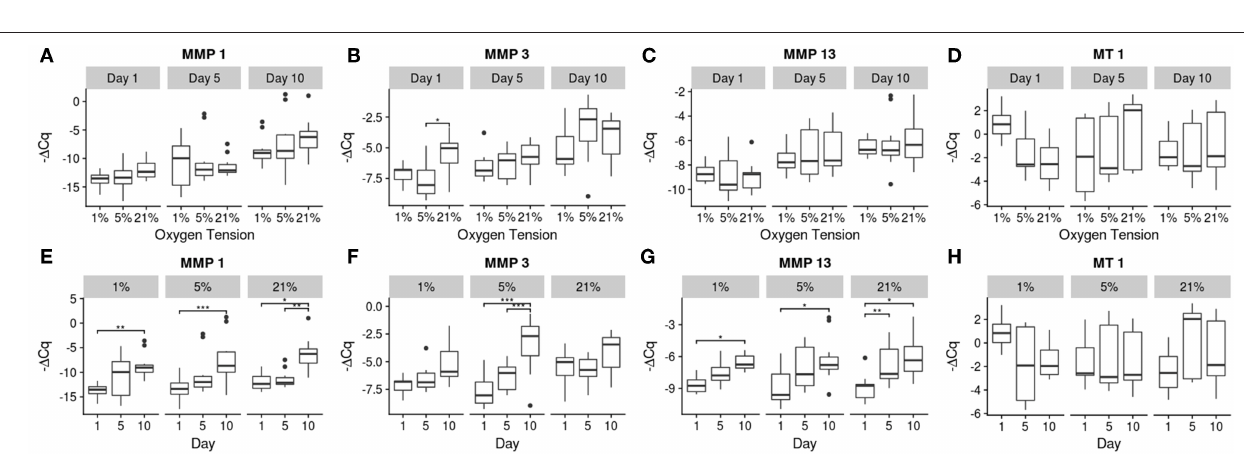
FIGURE 5 | Gene expression of the catabolic genes using - 1 Cq values. The top row (A–D) contains between oxygen tension group comparisons over the days, while the bottom row (E–H) contains changes over time within each oxygen tension group. Significance shown as * p ≤ 0.05, ** p ≤ 0.01, and *** p ≤